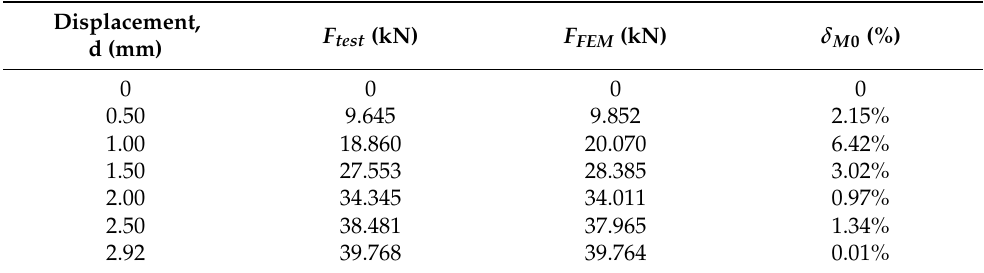
Table 5. The tabulation of the calculation versus the experimental test results for the Model 0 sample’s equilibrium path.